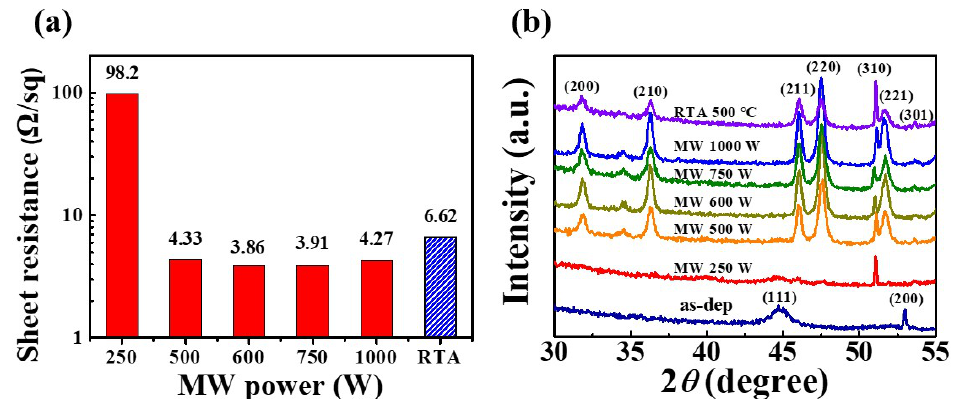
Figure 4. The R s values ( a ) and XRD spectra ( b ) of the NiSi x samples obtained via MWA at powers of 250 – 1000 W for 2 min, or via RTA at 500 °C for 2 min, under a N 2 atmosphere. The current–voltage (I-V) characteristics of the NiSi x Schottky junction diodes on n-